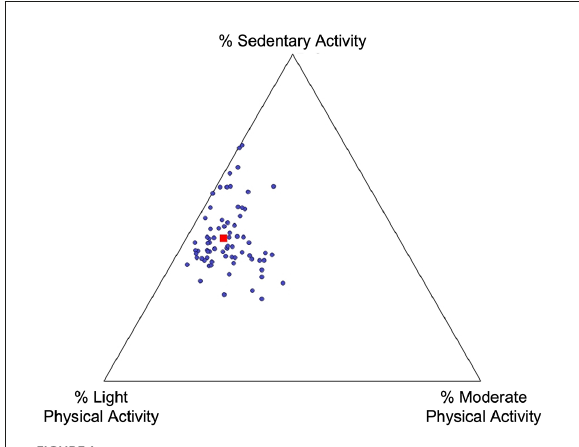
FIGURE1 Physical activity distribution. Each point represents one participant; their location on the plot represents the proportion of time spent engaged in moderate physical activity, light physical activity, and sedentary activity. The red square represents the mean breakdown of time across all participants.